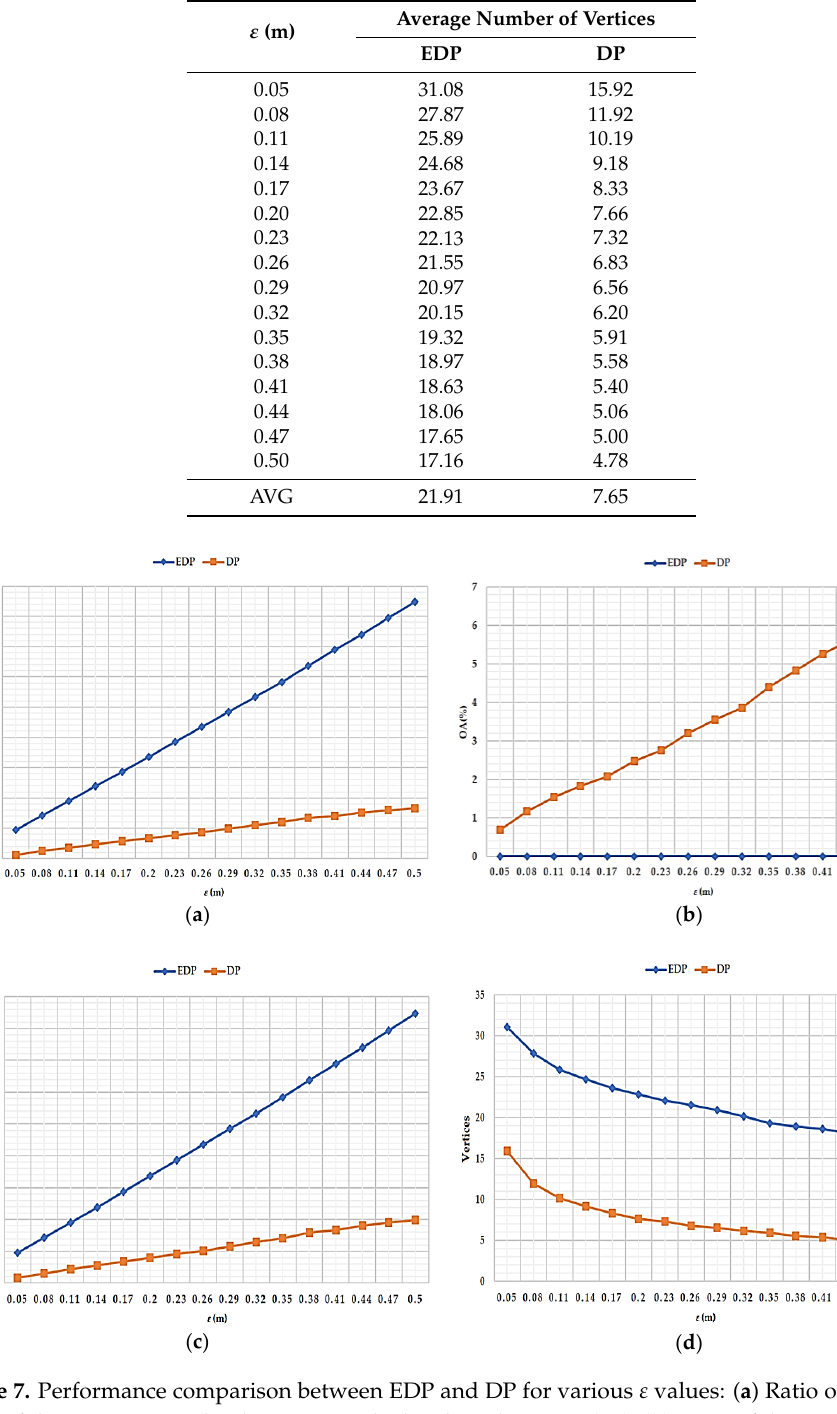
Figure 7. Performance comparison between EDP and DP for various ε values: ( a ) Ratio of the inner space of the approximated polygons outside the obstacle region (IA); ( b ) Ratio of the outer space of the approximated polygons inside the obstacle region (OA); ( c ) Sum of IA and OA (SA); ( d ) Average number of vertices created by EDP and DP (The numbers of obstacles and vertices of each obstacle were fixed as 15, and θ rot for EDP was fixed as 30°).